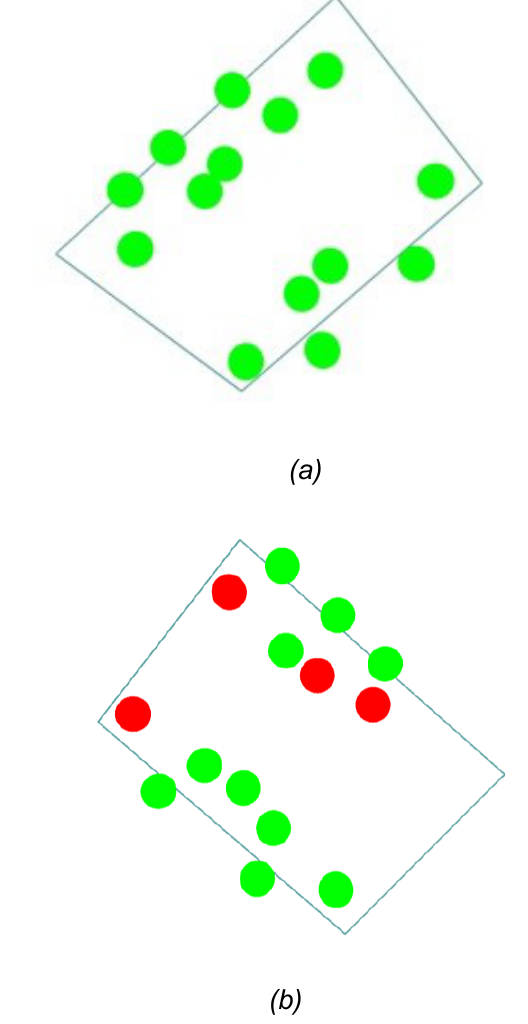
Figure 3: 2D floor plan of a room with (a) all correctly classified assets; (b) correctly detected assets (green) and misclassified/incorrectly detected (red) Figure 2: Screenshots of our system showing (a) correct detection of an outlet with confidence level of 93%; (b) correct detection of a light switch with confidence level of 87%; (c) incorrect detection of an outlet as lighting switch with confidence level of 9.7%; (d) dropdown menu showing the incorrect detection, which the user can correct; (e) user placing anchor in the correct place; (f) user drawing a bounding box around the object to enable the system to use this image for future training.